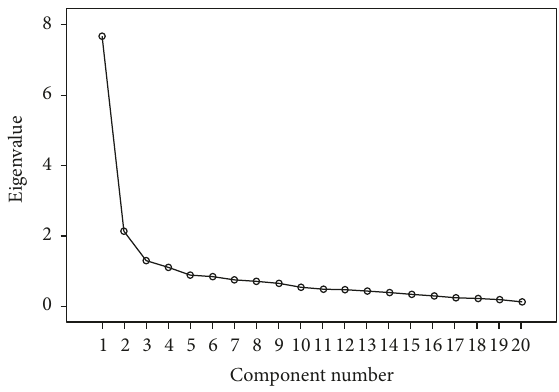
Figure 2: Scree Plot of the psychiatric outpatients.